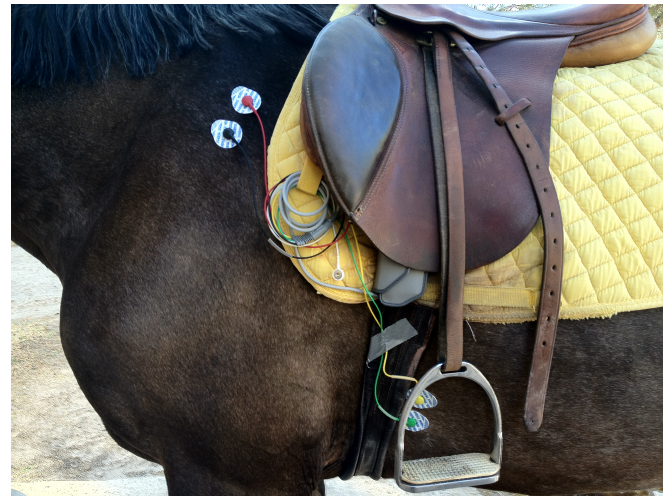
Figure 2. A horse with the electrodes for the exercise electrocardiography already placed.